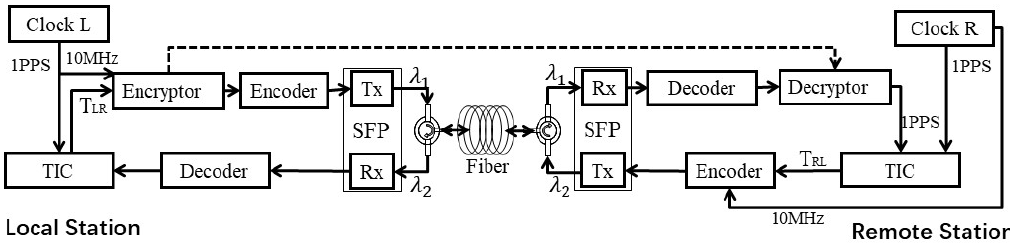
Figure 1. Schematic diagram of a safety optical fiber time transfer.